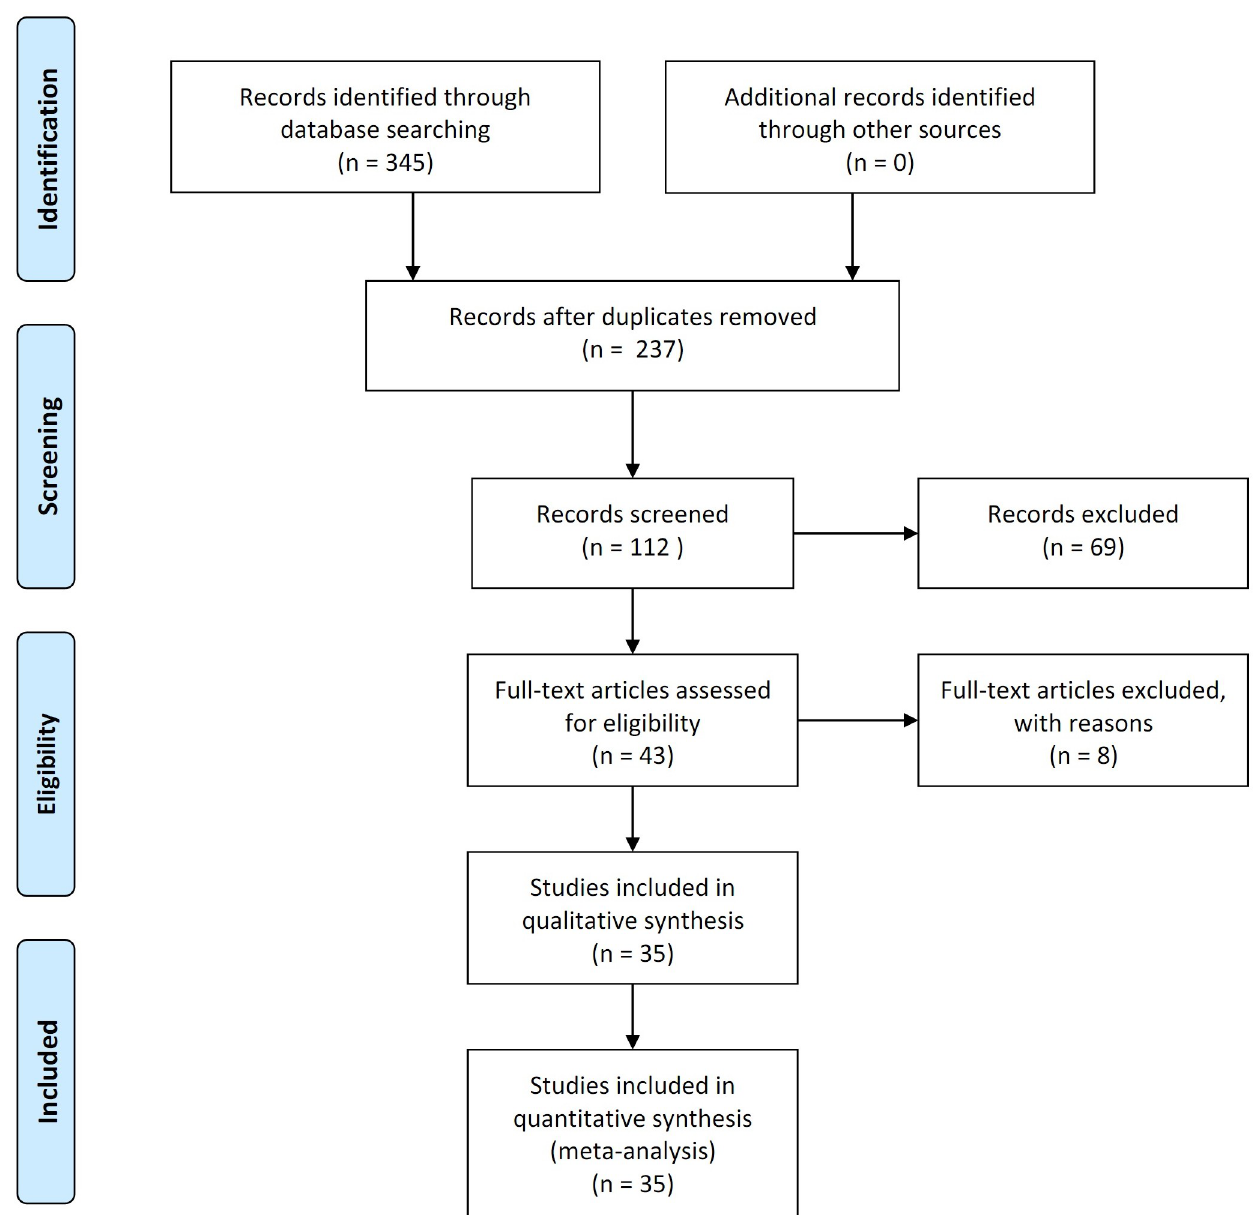
Fig 1. Flow diagram of evidence acquisition. Thirteen studies were ultimately included in the qualitative and quantitative review that used pairwise and network meta-analyses.